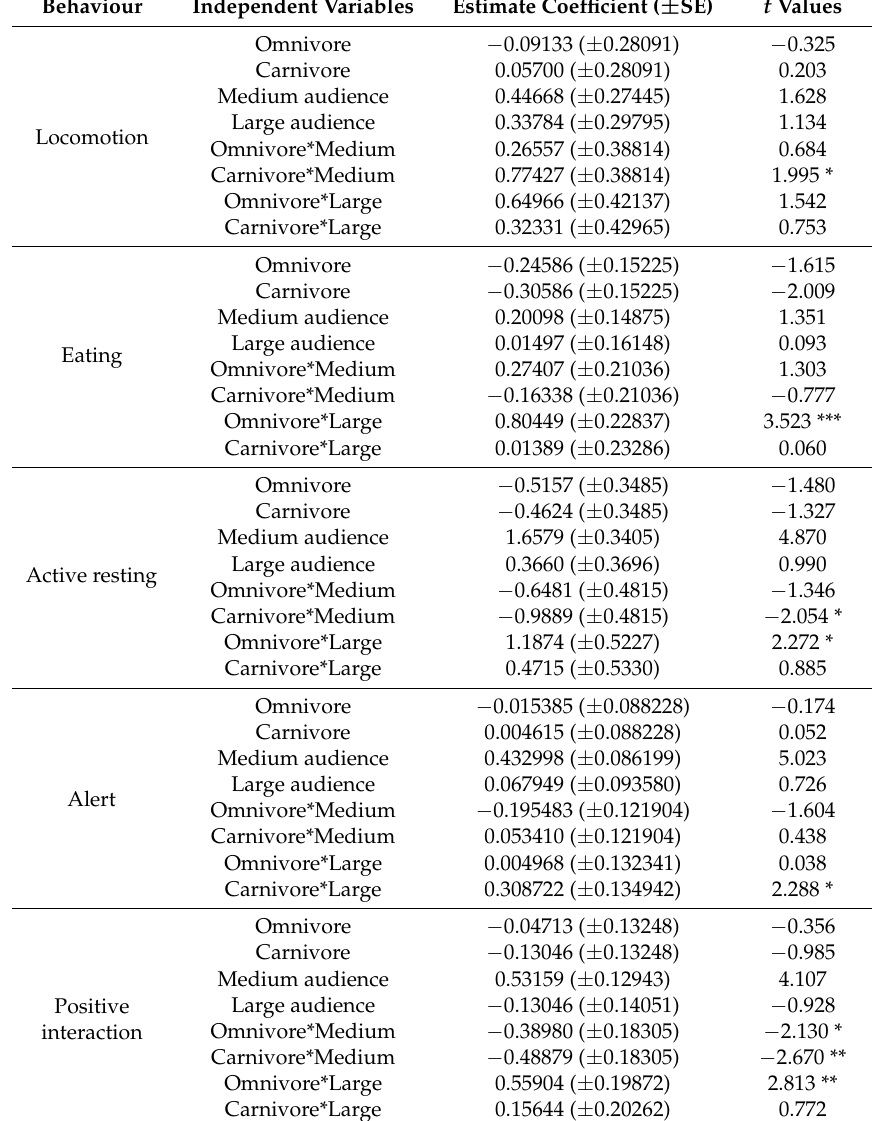
Table 6. Behaviours of zoo mammals significantly affected in the three types of diet analysed (herbivore, omnivore, and carnivore) and by public category (small, medium and